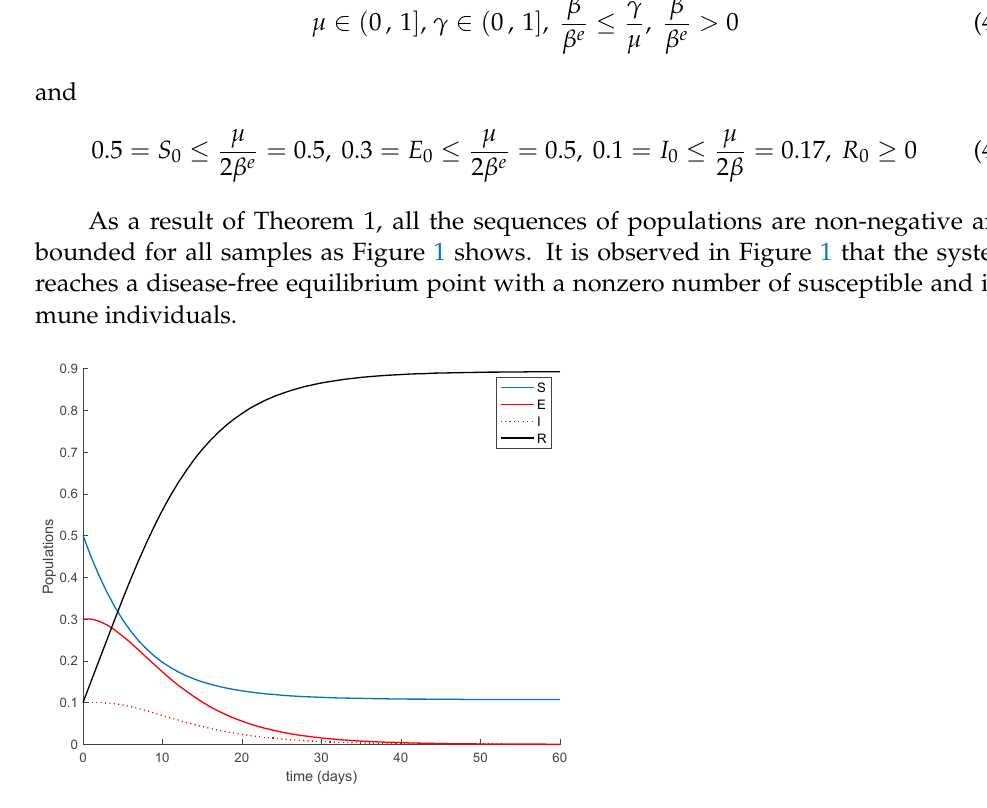
Figure 1. Sequences of populations for Case 1.1 conditions.